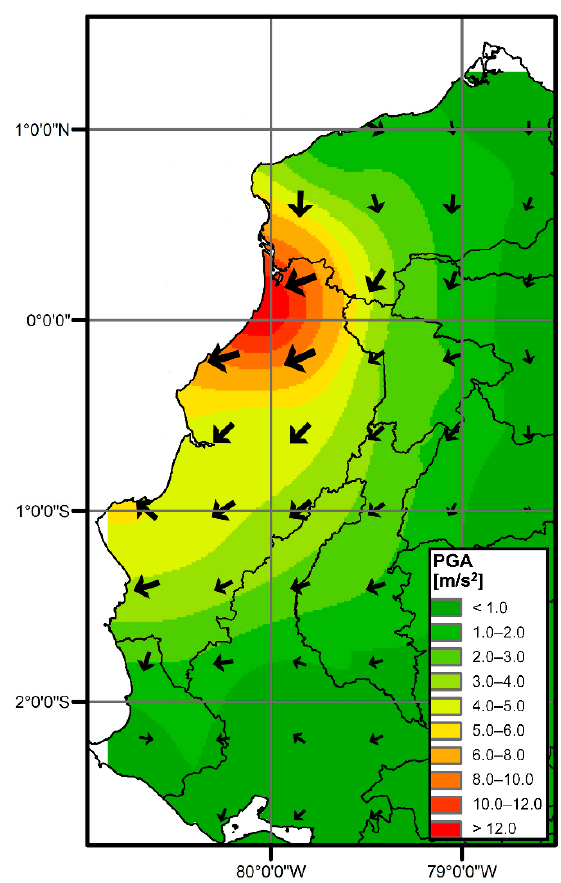
Figure 3. Flow direction of the PGA max in the horizontal plane during the 2016 Ecuador earthquake.